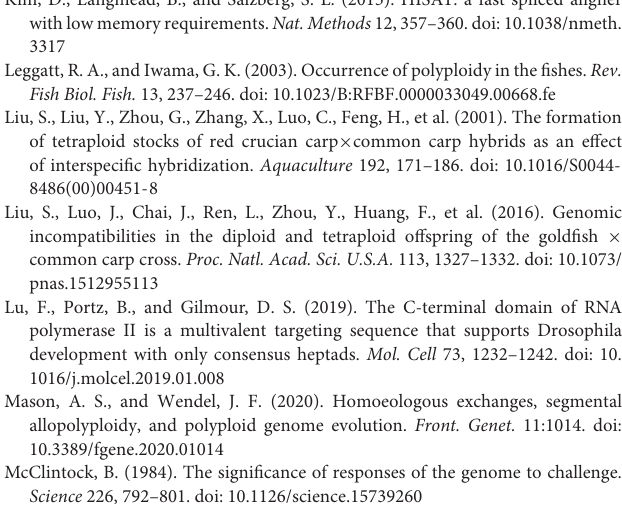
Supplementary Table 1 | Statistics of signal numbers in somatic cells of RCC. Supplementary Table 2 | Statistics of signal numbers in germ cells of RCC, CC,